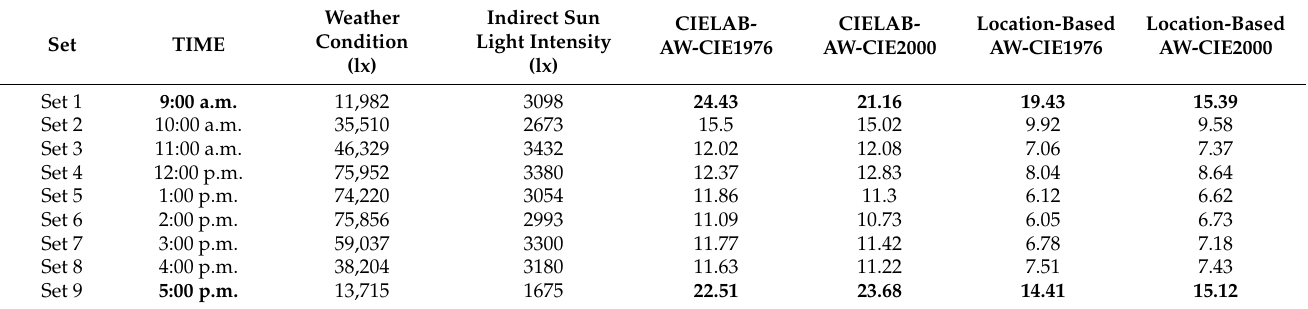
Table 7. Luminous intensity captured from 9 a.m. to 5 p.m. using Samsung S 10 smartphone under direct sun light and indirect sunlight (shadow on the book). In addition, average prediction rank using CIELAB colour model and CIE1976 and CIE2000 distance functions. Location-Based—Prediction using only prominent soil colours in Australian topsoils. AW—Proposed weight difference from Table